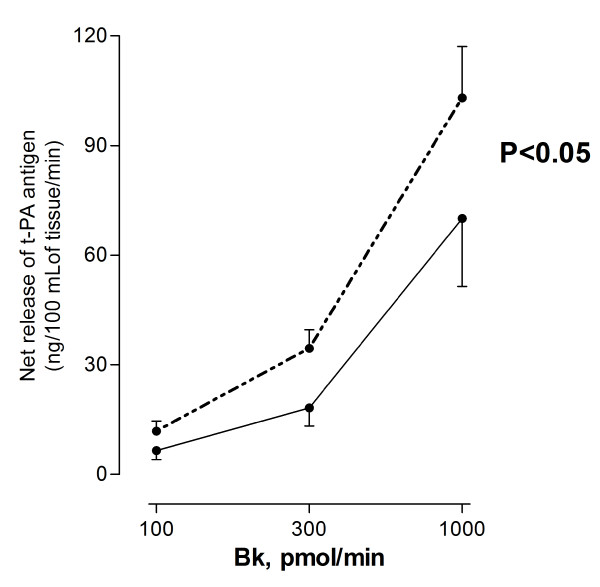
Net release of t-PA antigen in the infused arm during unilateral intra-brachial infusion of bradykinin (Bk) after diesel (solid line) and air (dashed line) exposures. Effect of exposure compared using 2-way ANOVA with repeated measures. Data plotted as mean ± SEM.